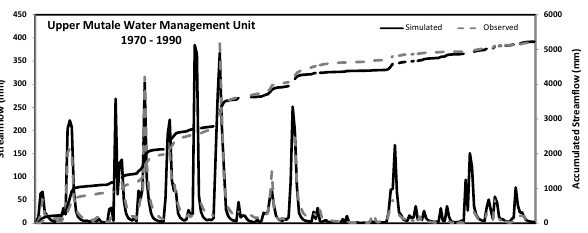
Fig. 9. Comparison of monthly totals of daily simulated and ob- served streamflows for the Upper Mutale WMU of the Luvuvhu Catchment.